Question: Name the type of graph shown.
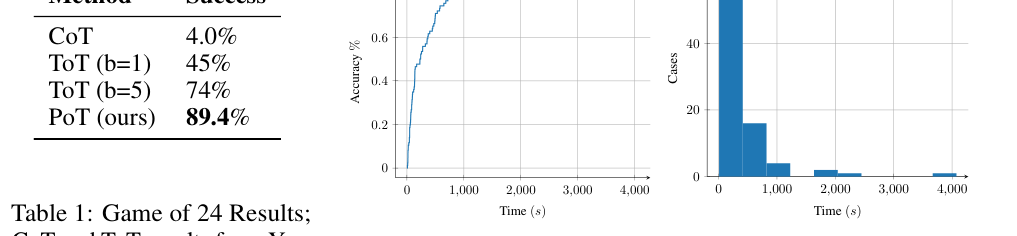
Answer: line